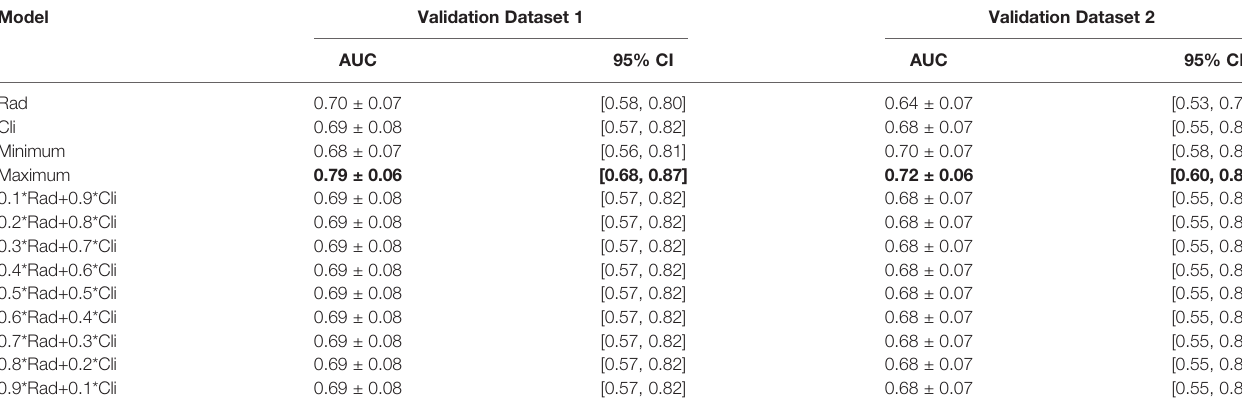
TABLE 2 | The diagnostic performance of different combination of radiomics and clinical features.